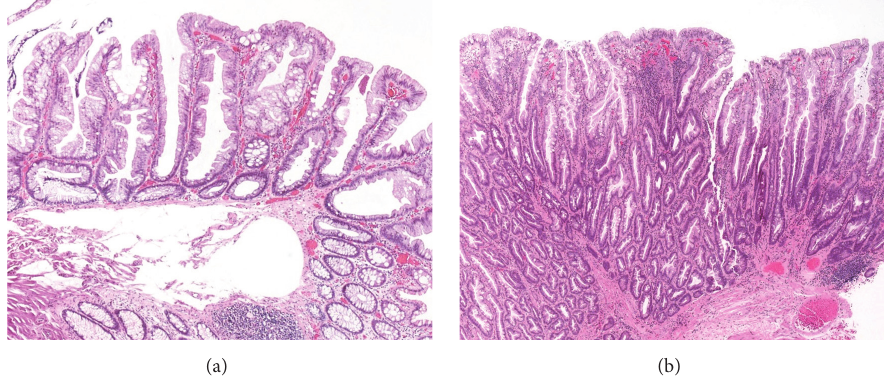
Figure 1: Representative histology with H&E staining of (a) a sessile serrated adenoma or polyp (SSA/P) and (b) a traditional serrated adenoma(TSA).SSA/Psgenerallyshownooronlyfocalconventionalcytologicaldysplasia,havebasalflatteningordilationofcrypts,andhave exaggerated apical cytoplasm creating a serrated morphology. TSAs have cytologic dysplasia throughout, have hypereosinophilic cytoplasm, and have a serrated morphology formed primarily by multiple adjacent complex buds (ectopic